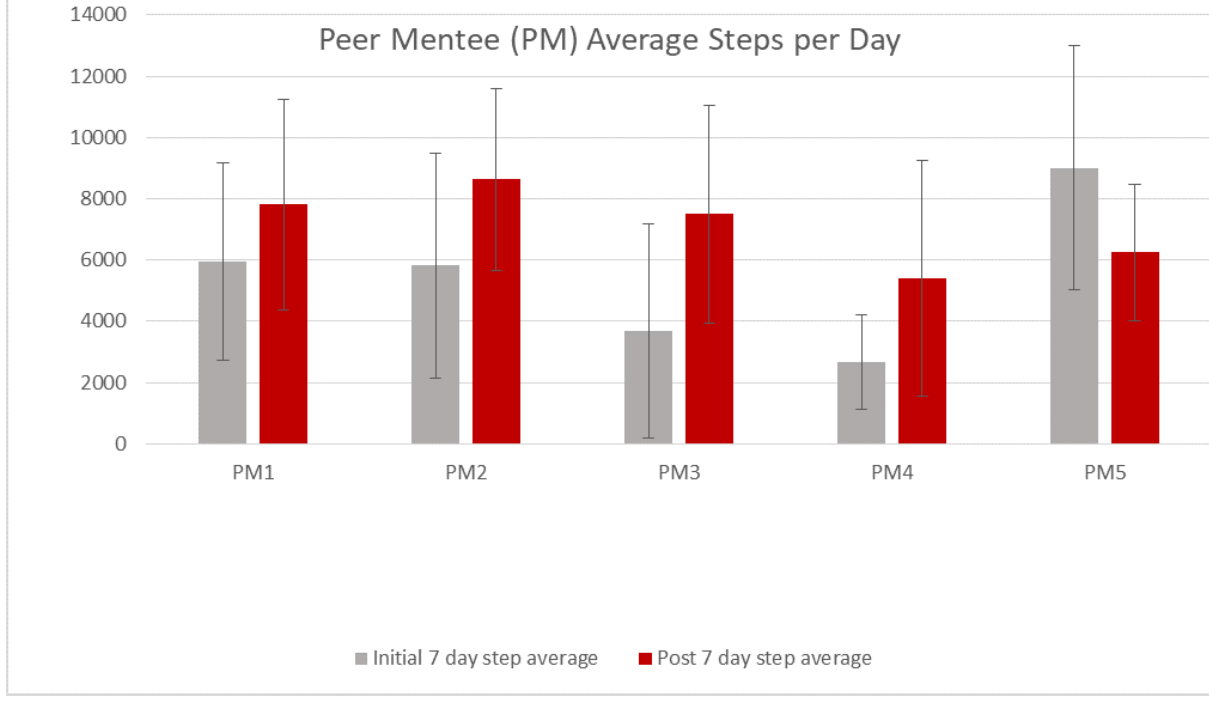
Figure 2. Peer mentees' initial and post average steps per day.